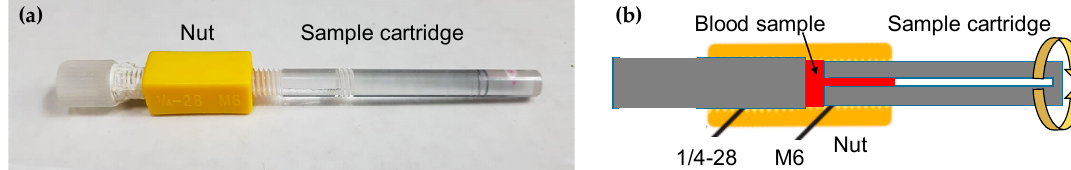
Figure 1. ( a ) Photograph of an assembled nut-and-bolt sample cartridge with a reaction chamber. ( b ) Cross section of a nut-and-bolt microfluidic reaction chamber formed by a nut (yellow) and a bolt-like sample cartridge (grey). The reaction chamber is filled with a blood sample (red).